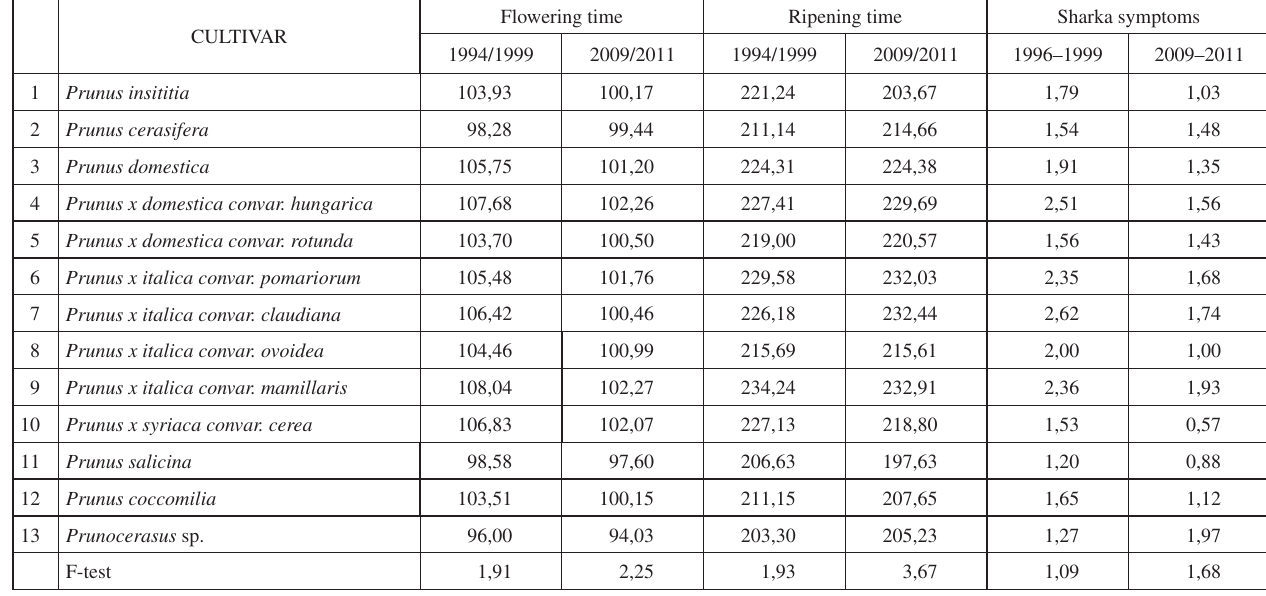
Table 8. Characterization of plum taxons with phenological and sharka symptom traits (mean) Flowering time Ripening time Sharka CULTIVAR